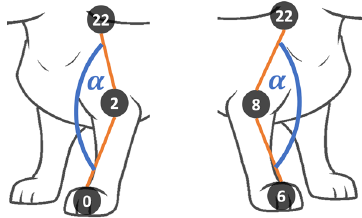
Figure 8. Calculation of the front leg